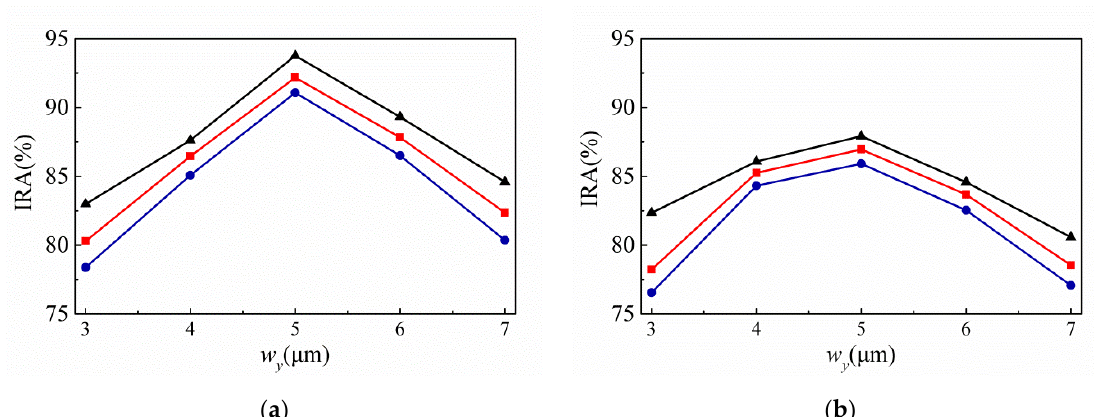
Figure 4. Variances of the infrared absorbance (IRA) with different ρ by the function of w y for the thermopiles with SA type ( a ) and MA type ( b ) of SRHA of w x = 15 μm, where the solid lines with triangle, square, and round represent the cases of ρ = 2.5 μm, ρ = 3μm, and ρ = 3.5 μm, respectively.